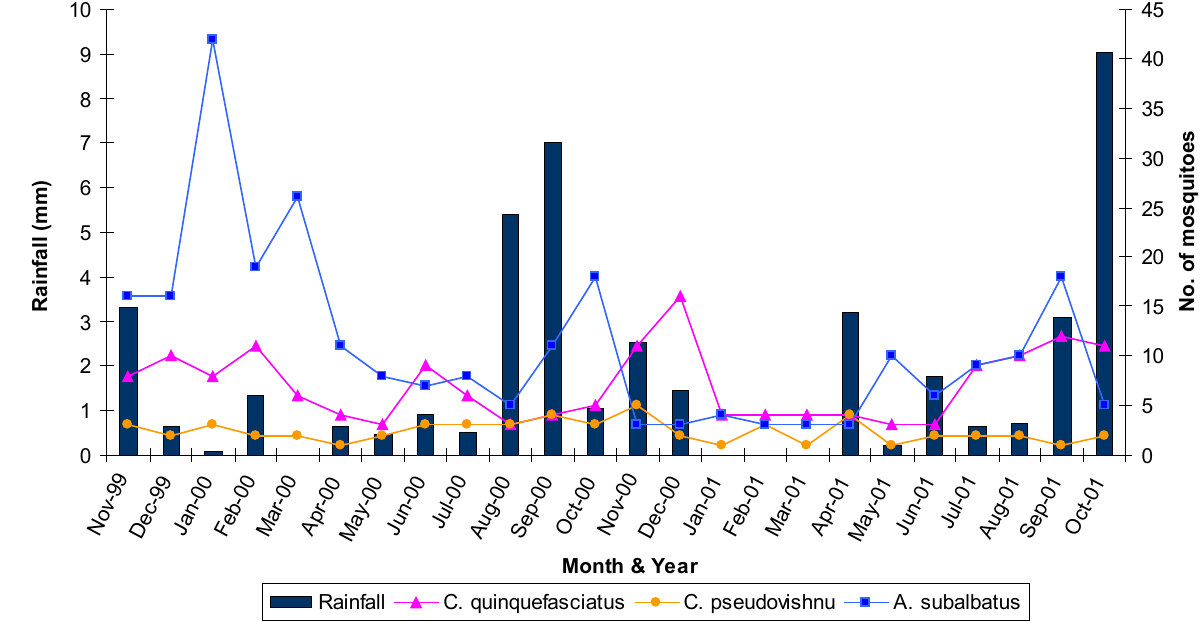
Figure 6. Population dynamics of mosquito species in relation to rainfall in